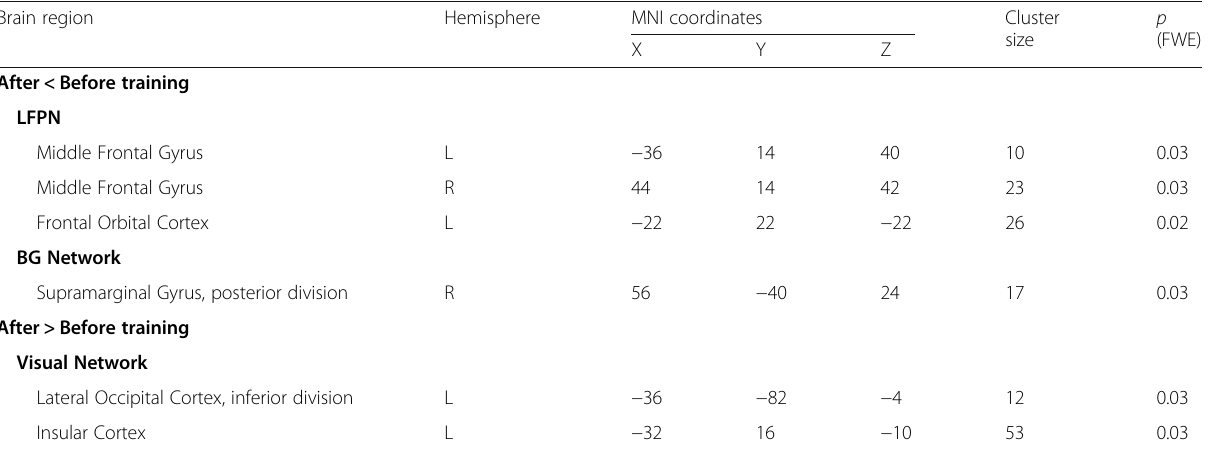
Table 4 Regions with changed functional connectivity in functional illiterates after training ( n = 20) compared to before training in different networks